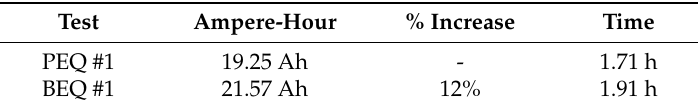
Table 1. Discharge data with 24 GAIA cells.